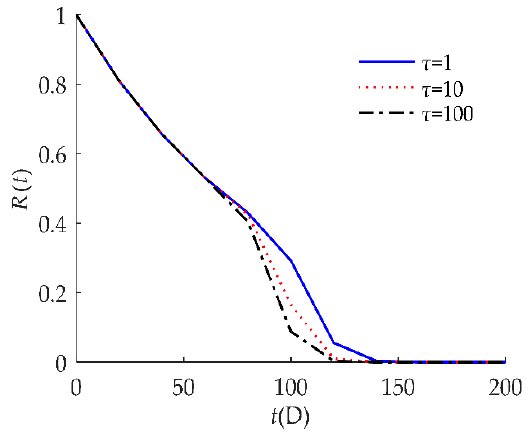
Figure 11. Sensitivity analysis of R ( t ) on D for example II. Figure 12. Sensitivity analysis of R ( t ) on H for example II.